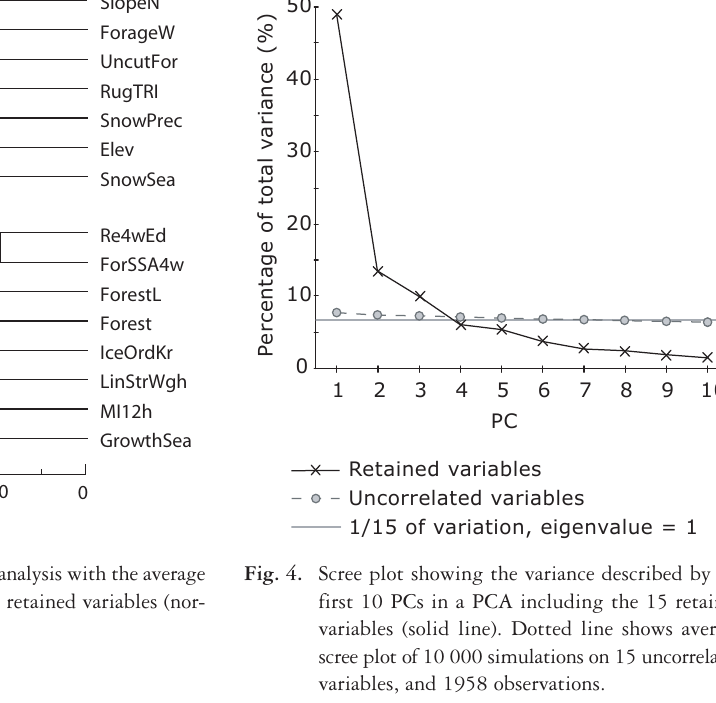
Fig. 3. Dendrogram from cluster analysis with the average linkage method of the 15 retained variables (nor- malized values).